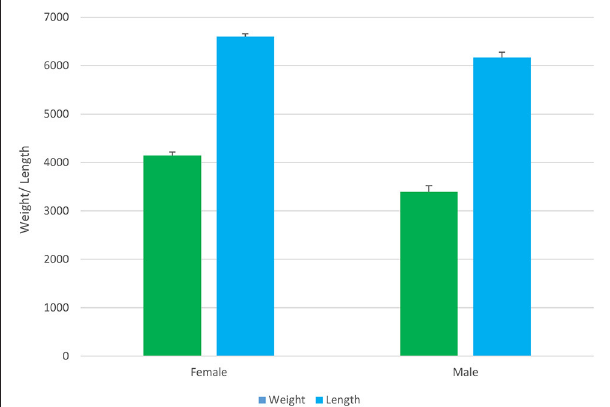
2058) and tank ( n 576) over = =